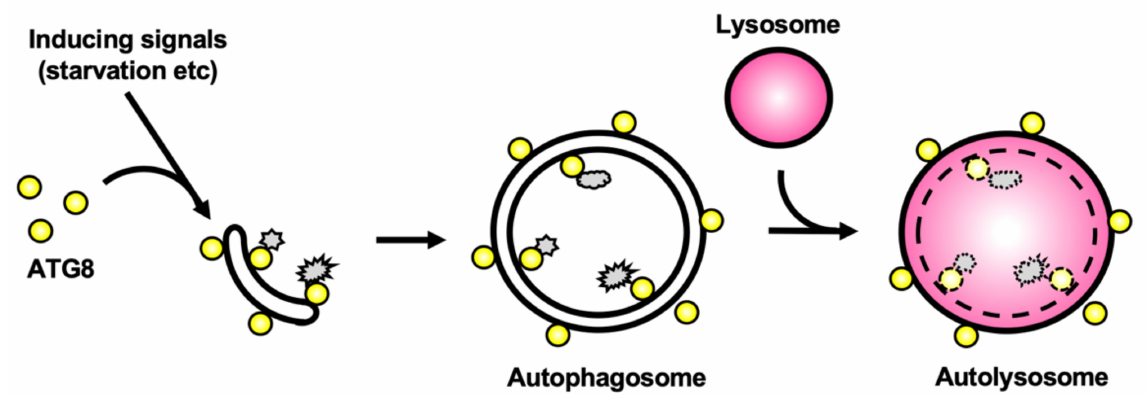
Figure 1. Schematic diagram of autophagy in mammals. Starvation and other stresses induce autophagy and ATG8-family proteins are recruited onto the autophagosome membrane. Proteins harboring an LC3-interacting region (LIR) motif can bind to ATG8-family proteins to be subsequently selectively degraded. Upon completion of the closure, autophagosomes and lysosomes fuse together to form the autolysosomes. The engulfed material (depicted in gray) is degraded and can be subsequently recycled. Notably, ATG8-family proteins are located both inside and outside the